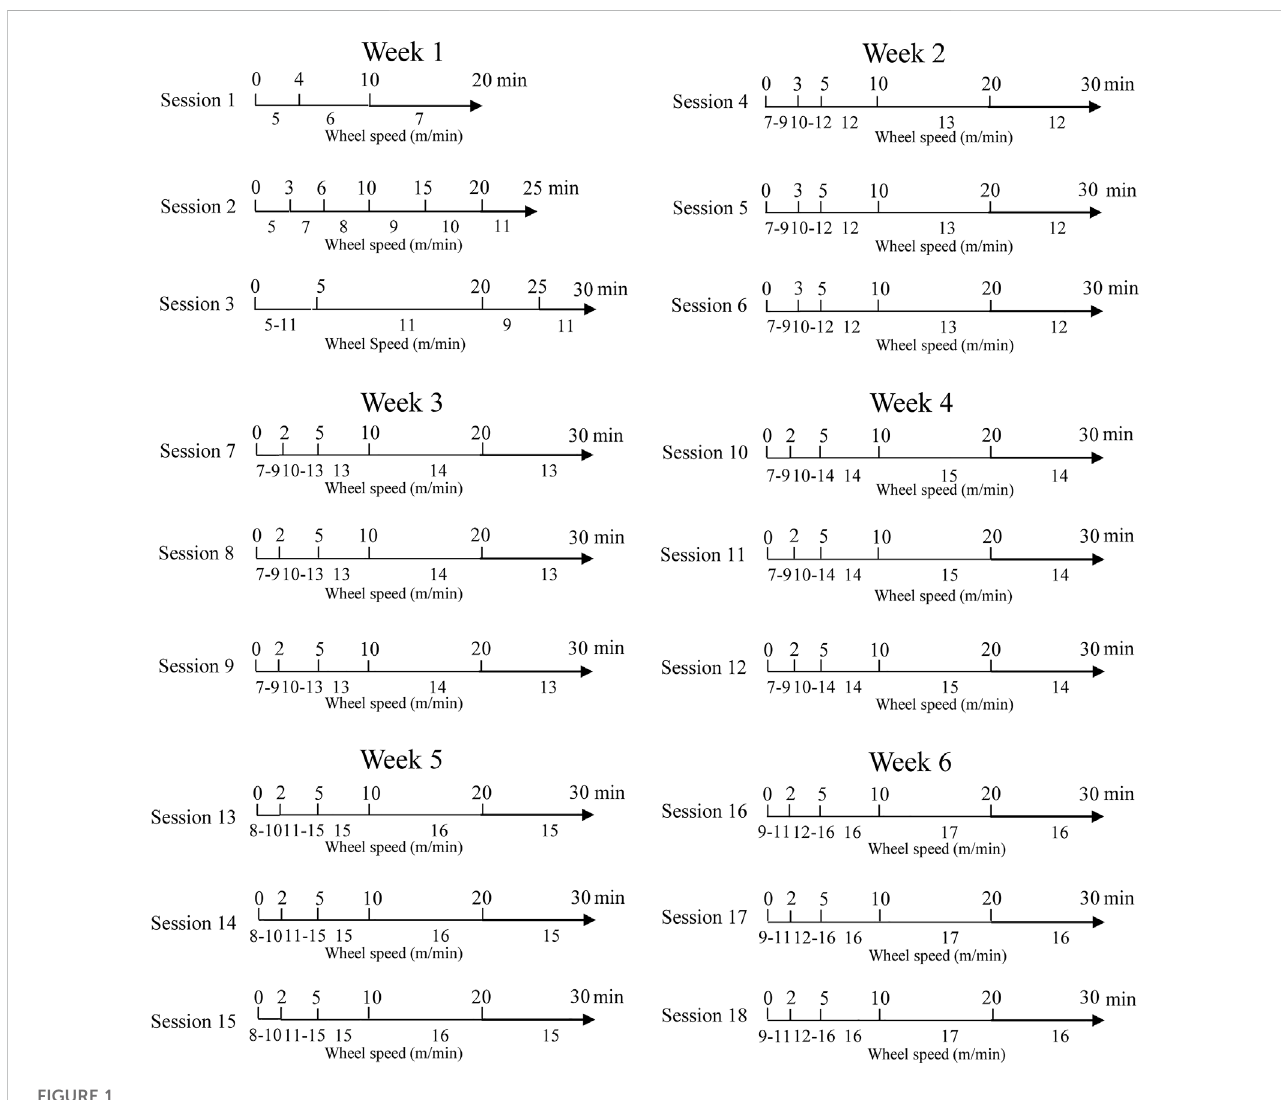
Exercising session